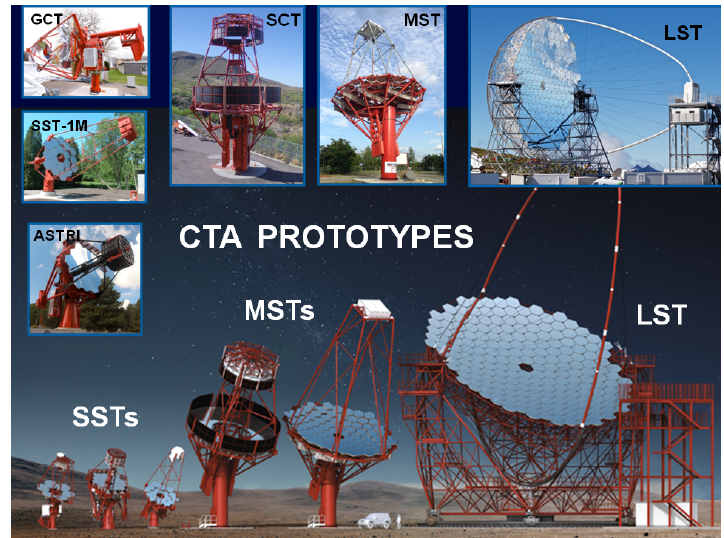
Figure 5. Concept drawings and photographs of CTA protoype telescopes, as of 2018. Clockwise (from lower left): SST-ASTRI at Mt. Etna, Italy, SST-1M at Krakow, Poland, SST-GCT at Meudon, France, SCT at